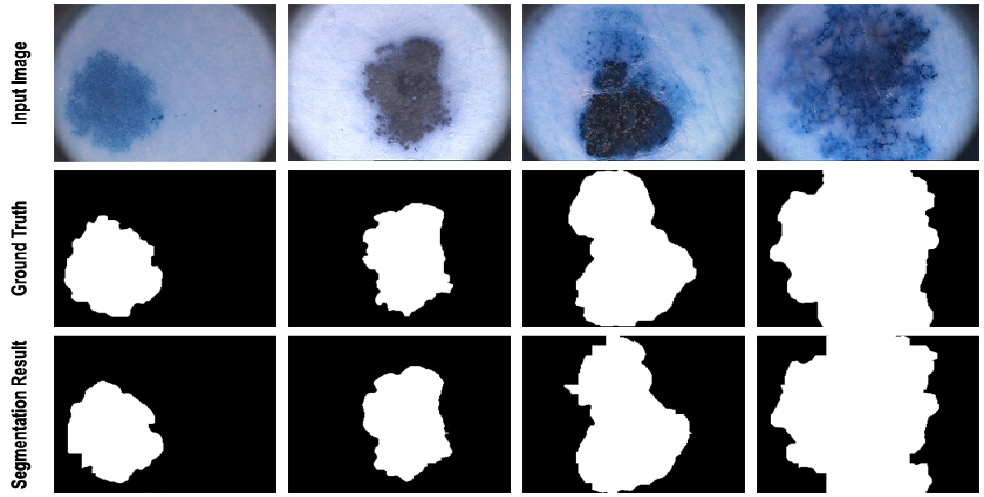
Figure 5. Segmentation results of the proposed method on PH². The segmentation results illus- trate that the proposed method accurately segmented the skin lesion area from the surrounding tissue region.